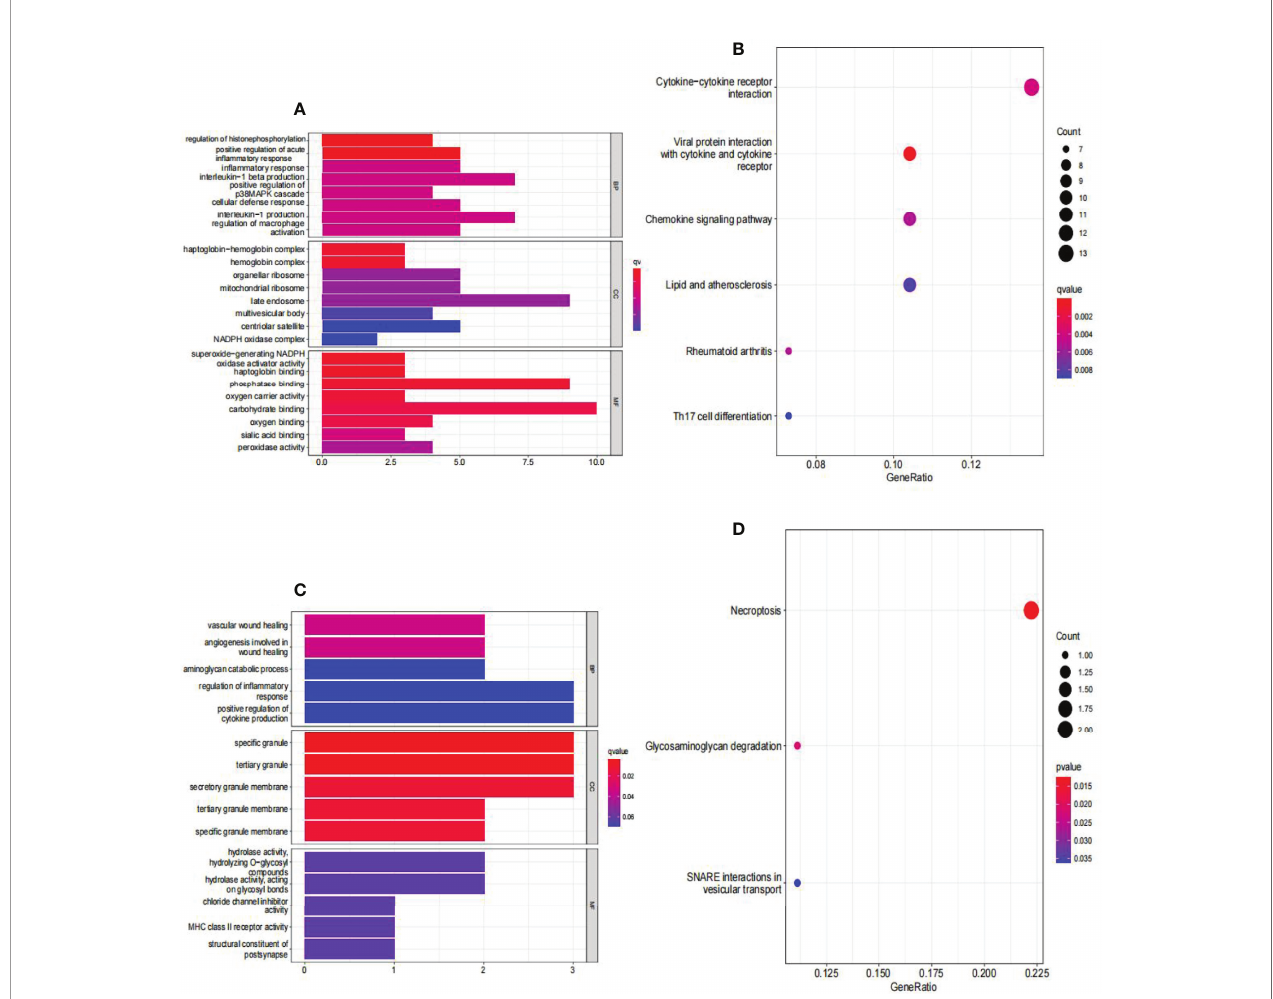
FIGURE 6 | AnalysesoffunctionalenrichmentofDEGsinGSE57691. (A) AnalysisofDEGs betweenAAAandnormalsamplesusingGeneOntology(GO)enrichmentanalysis. Thex-axisindicatesthenumber ofgenesassociatedwiththeterms, whilethey-axis indicates thepathwayterms. Eachterm ’ sq-valueis coloredaccordingtothe legend.BP, biologicalprocess;CC,cellularcomponent;MF, molecularfunction; (B) enrichmentanalysis ofDEGs betweenAAAandnormalsamplesusingtheKyotoEncyclopediaofGenes andGenomes(KEGG). Eachterm ’ sq-valueis coloredaccordingtothelegend.Differentcoloredbubblesre fl ectdifferentpathwayterms. (C) Enrichmentanalysis ofDEGs betweenlargeAAAandsmallAAAsamplesusing GeneOntology(GO). Thex-axisindicatesthenumber ofgenesassociatedwiththeterms,whilethey-axis indicatesthe pathwayterms.Eachterm ’ s q-valueiscoloredaccordingtothelegend. BP, biologicalprocess;CC,cellularcomponent; MF, molecularfunction; (D) Enrichmentanalysis ofDEGs comparinglargeAAAandsmallAAAsamplesusing theKyotoEncyclopediaofGenes andGenomes(KEGG). Eachterm ’ sq-valueis coloredaccordingtothe legend.Different coloredbubblesre fl ectdifferentpathwayterms.AAA,